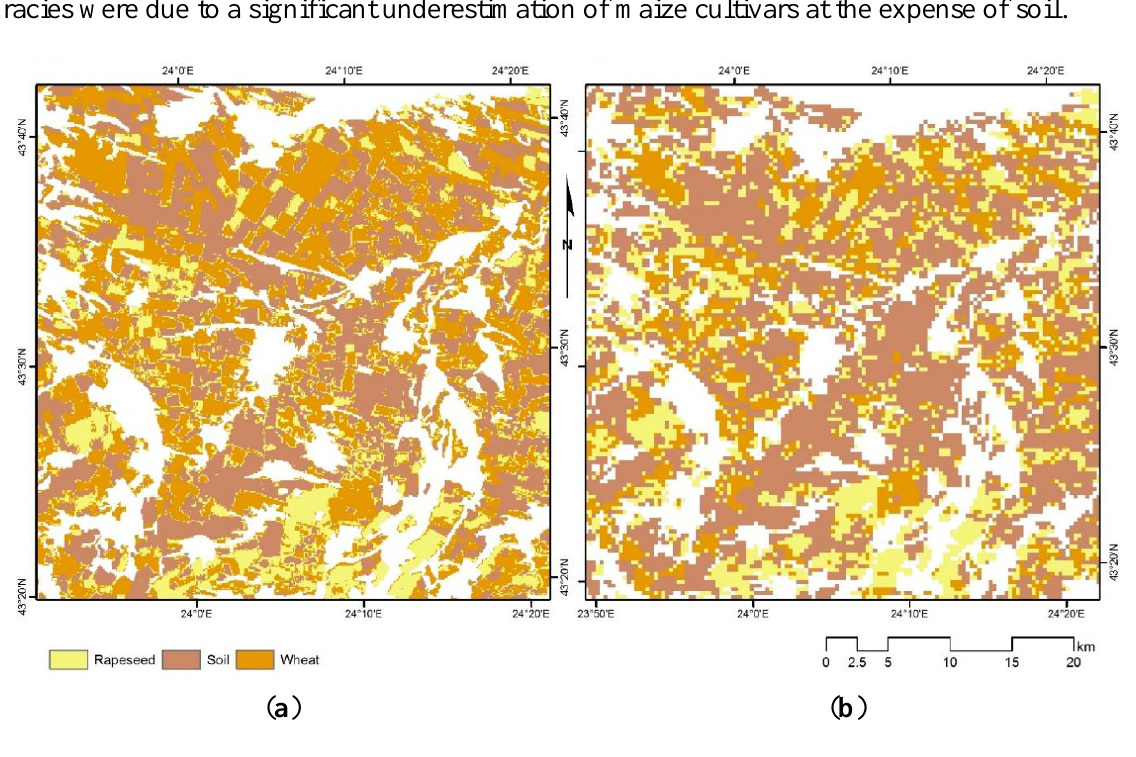
Figure 2. Classification results using PROBA-V ( a ) 100 m and ( b ) 300 m multi-spectral images from 21 March 2014 (SINGLE1 experiment) for mapping bare soil, wheat and rapeseed. Note that areas outside the CORINE class 211 (agriculture) were left blank. Table 6. Error matrix of the supervised MLC classification for PROBA-V 100 m SINGLE3 (7 June 2014) using the random sampling dataset (e.g., n = 275 in Figure